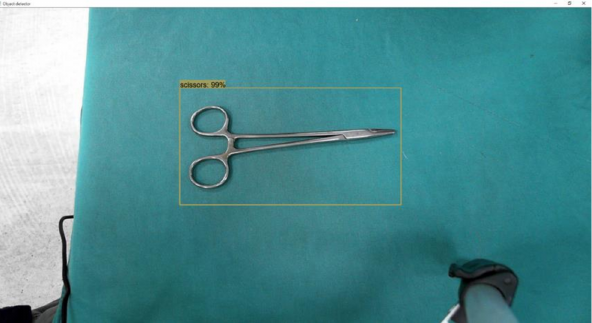
Figure 6. A pair of scissors (general) correctly detected and identified by all